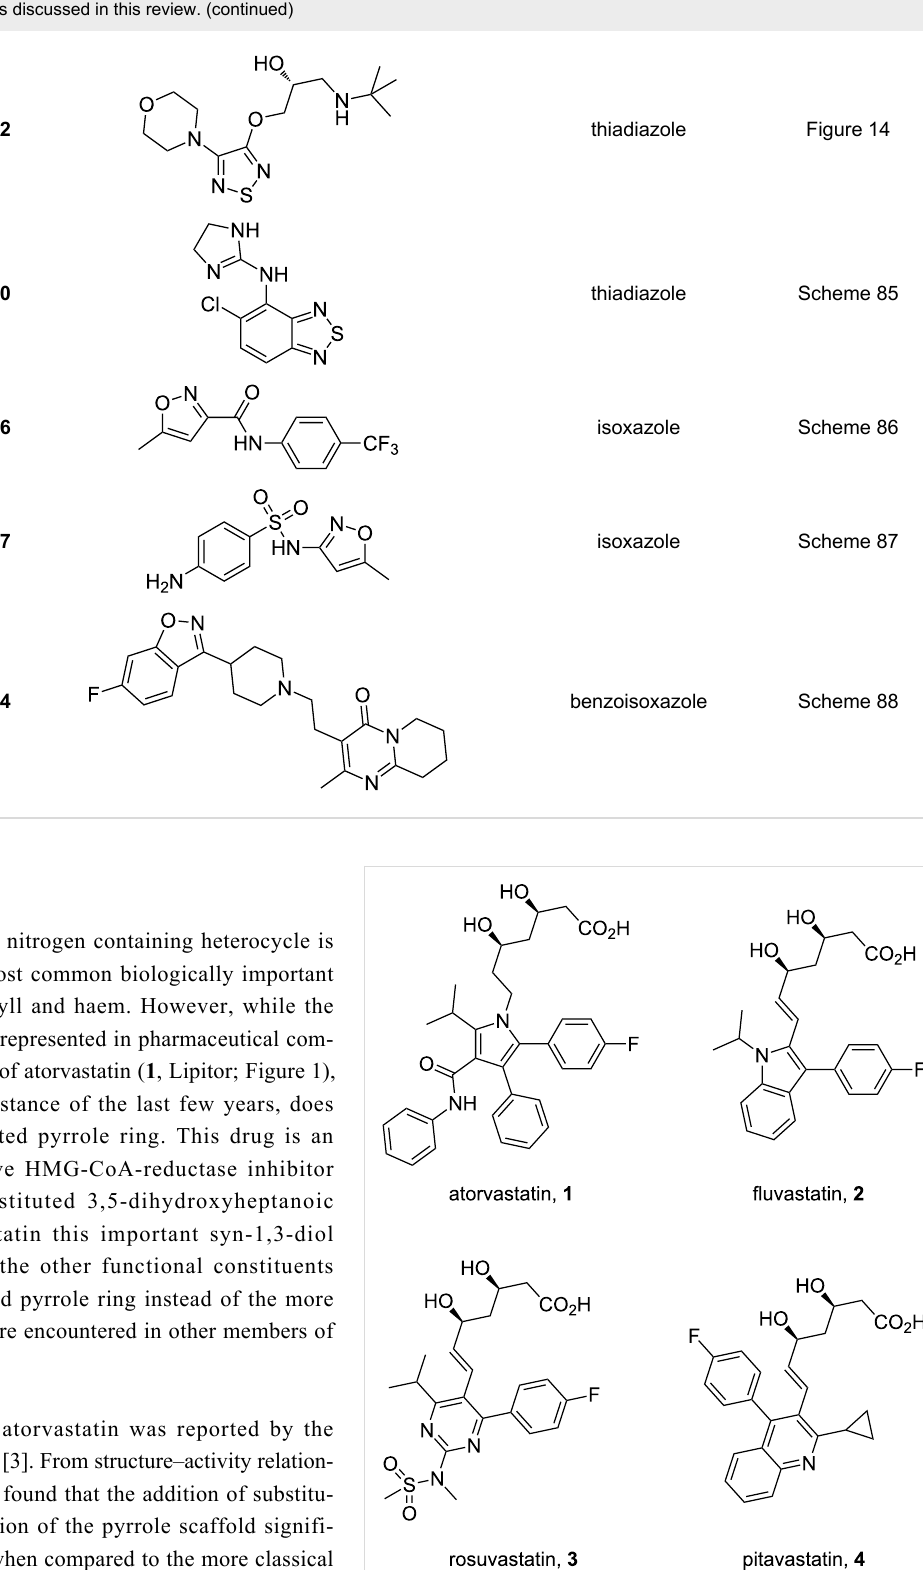
Table 1: Heterocylic structures discussed in this review. (continued)